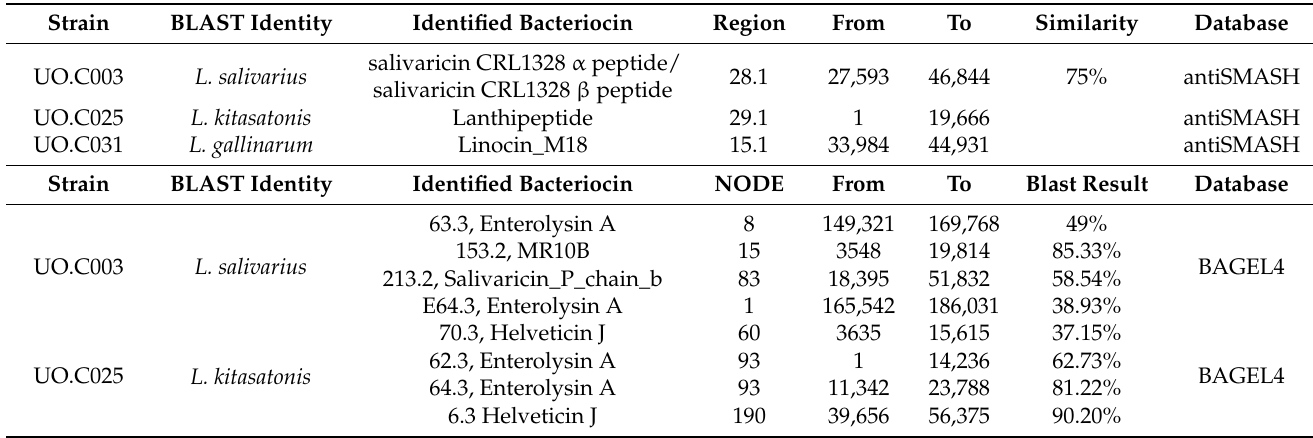
Table 4. Overview of all the bacteriocin genes that were identified, their location, and their similarity to BLAST search using both antiSMASH and BAGEL4. Strain